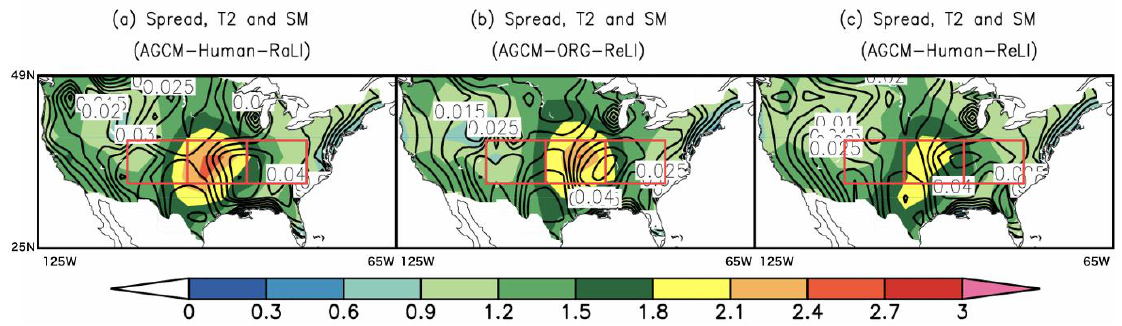
Figure 4. The spread of near-surface air temperatures (K) among 10 ensemble members for the periods from Days 16–39 from the initial date of the forecast simulations. The same as near-surface air temperature but for surface soil moisture (mm) is plotted by contour lines. The spread was averaged between 1986 and 1995. ( a ) AGCM–Human–RaLI, ( b ) AGCM–ORG–ReLI, and ( c ) AGCM–Human–ReLI. The three areas with black solid lines were used to discuss the spread of surface soil moisture.